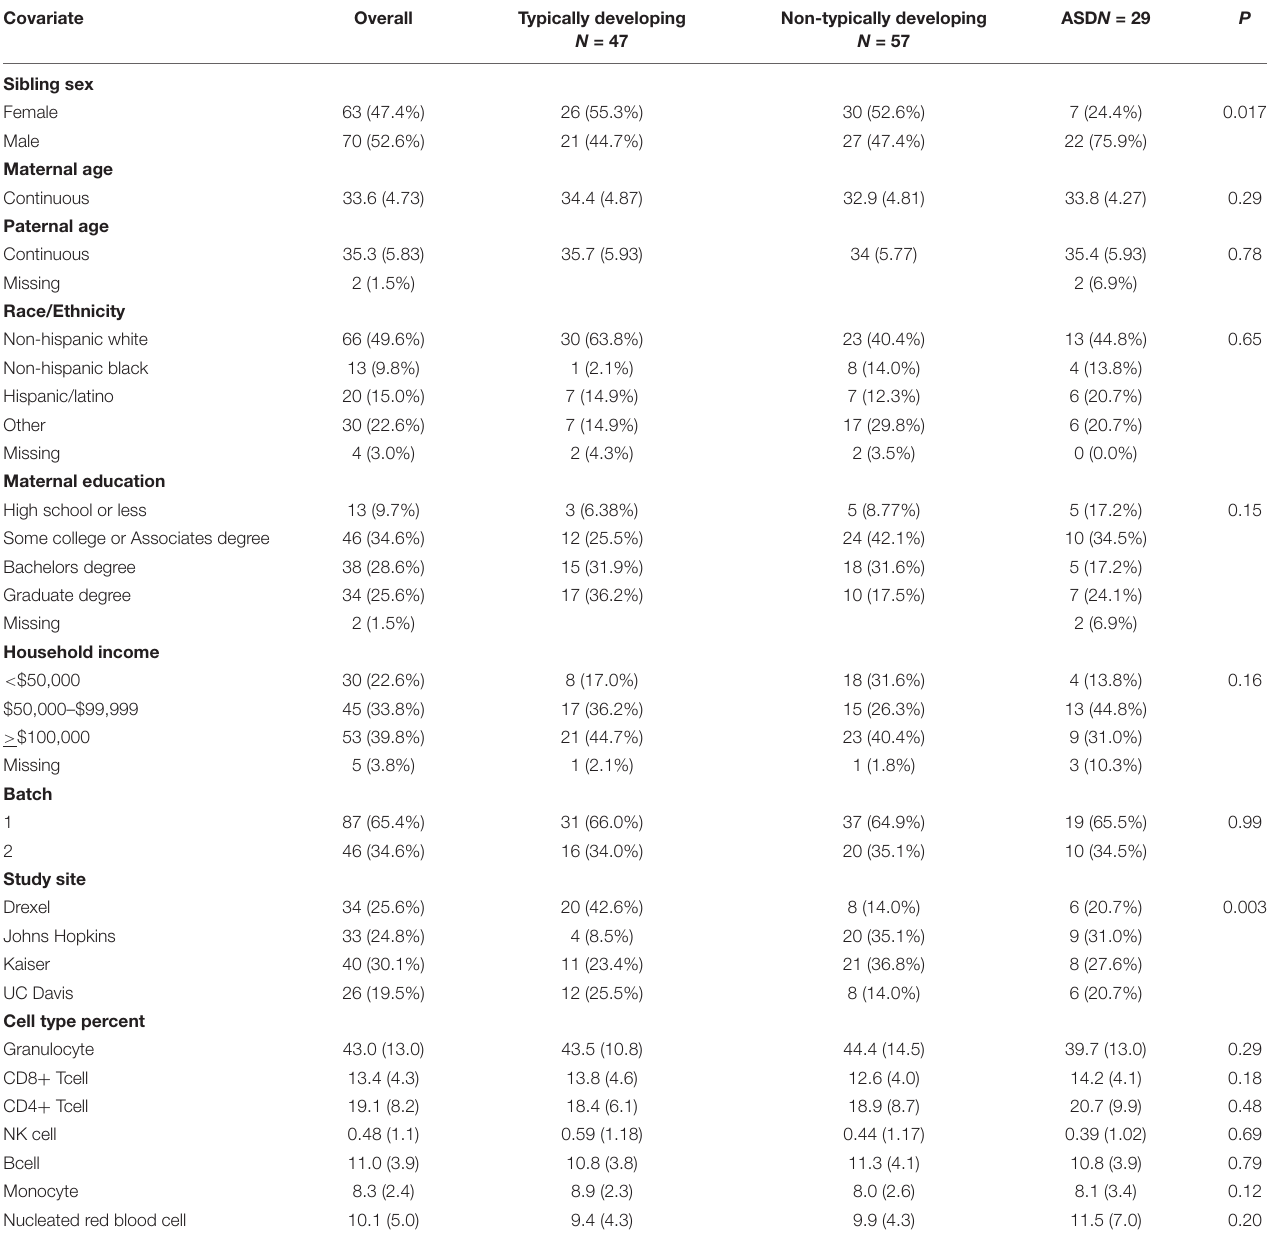
TABLE 1 | Cord blood study sample descriptive statistics by Baby Siblings Research Consortium algorithm typically developing, non-typically developing, and autism spectrum disorder (ASD) categorization. Covariate Overall Typically developing